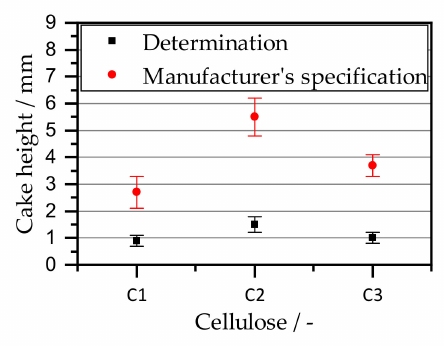
Figure 9. Cake height of the precoat